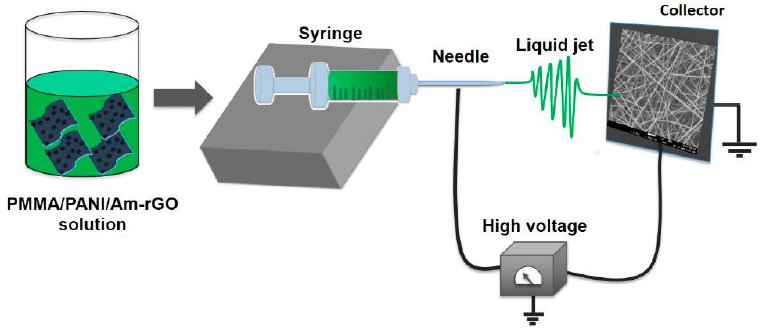
Figure 1. Schematic illustration of the electrospinning setup.